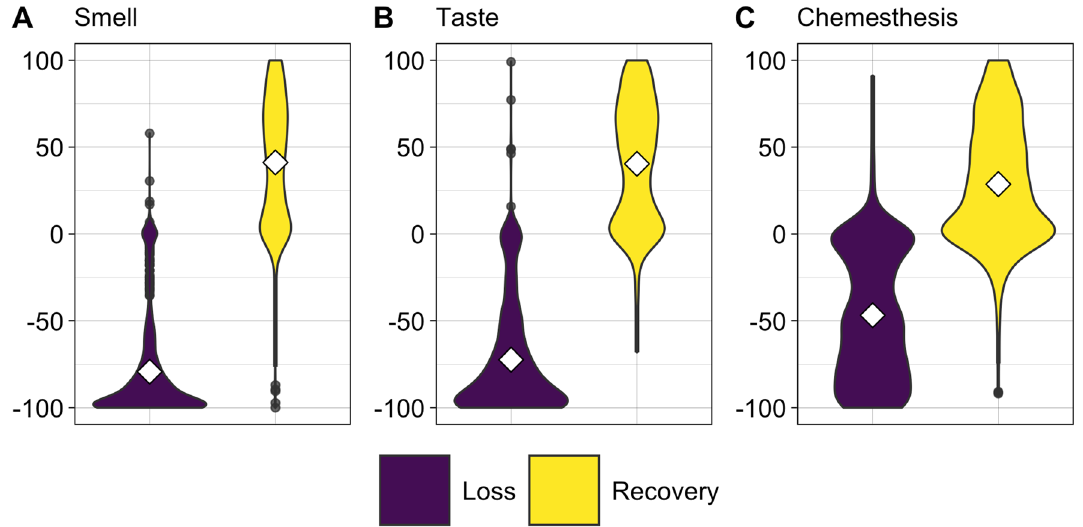
Figure 1. Loss (during—before ratings; violet) and recovery (after—during ratings; yellow) of smell ( A ), taste ( B ), and chemesthesis ( C ). Violin plots represent the smoothed distribution of data; white diamonds indicate the mean; whiskers indicate maximum and minimum values.